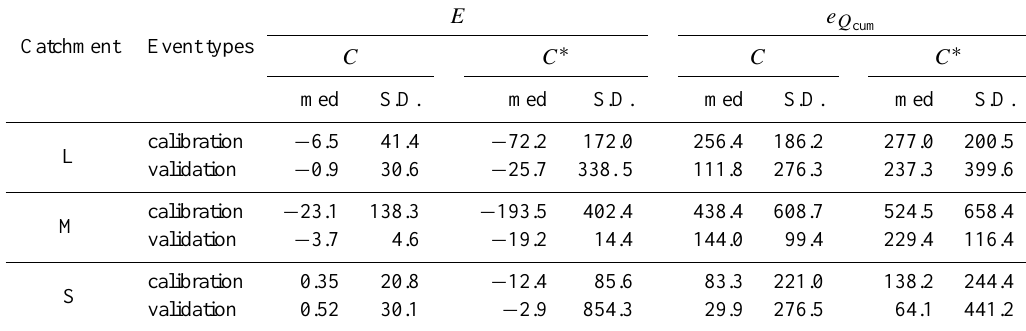
Table 10. Performance of non-calibrated closure relations evaluated for calibration and validation events.